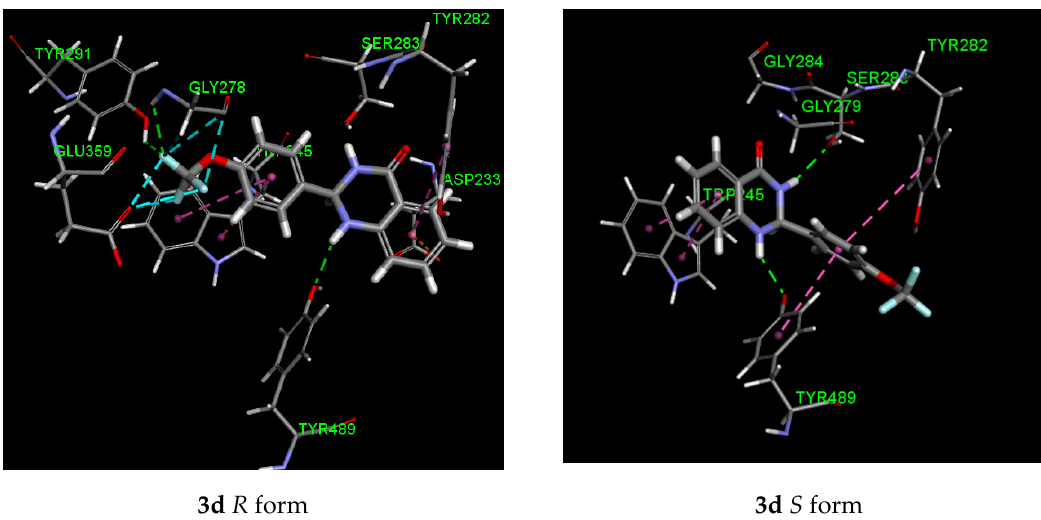
Figure 4. Predicted binding mode of both enantiomers of 3d in the G199S mutant AChE receptor (PDB: 6ARY). The molecular interactions are represented as green dotted lines for H-bonds, magenta dotted lines for π – π stacking interactions, and cyan dotted lines for fluorine contacts.